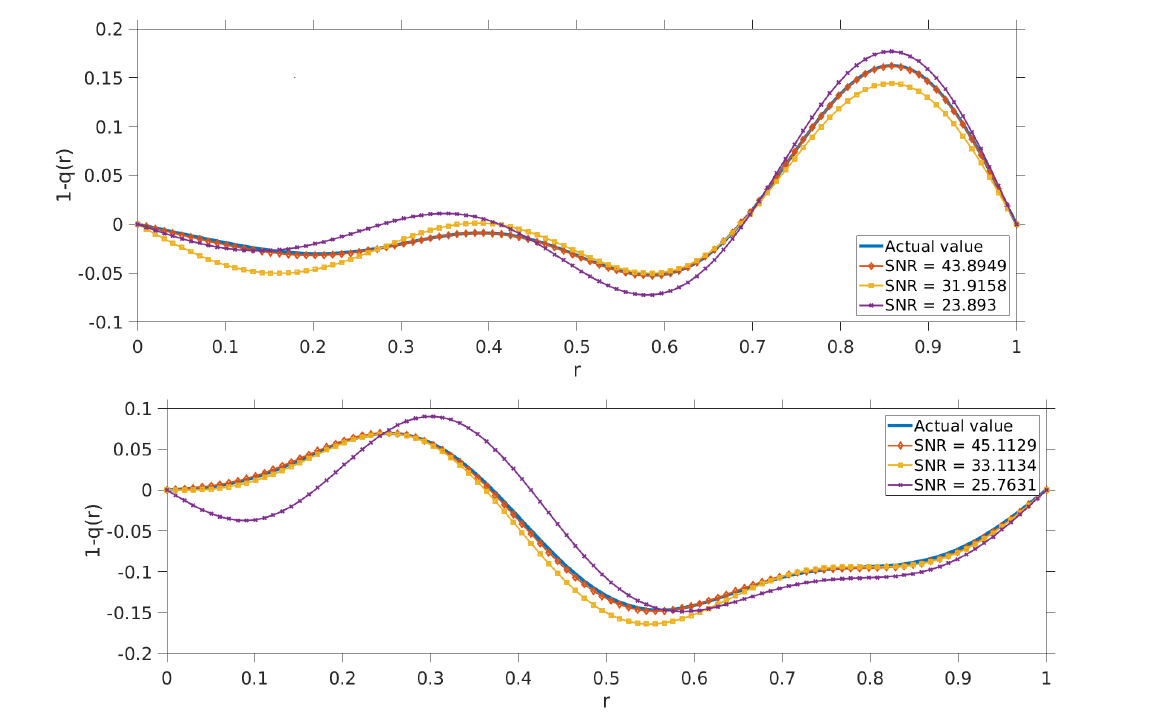
Figure 5. Refractive indexes from noise data with different SNRs reconstructed by the trained model for X 5 with k =